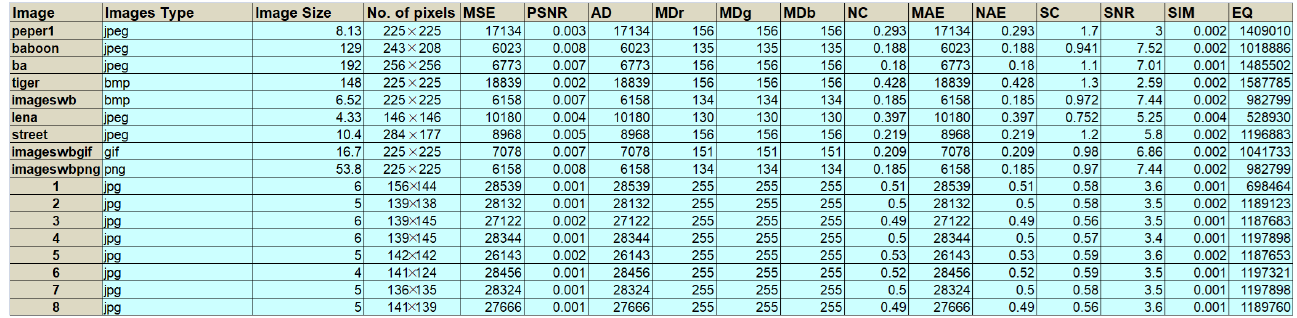
Figure 8. Results of statistical tests for the proposed